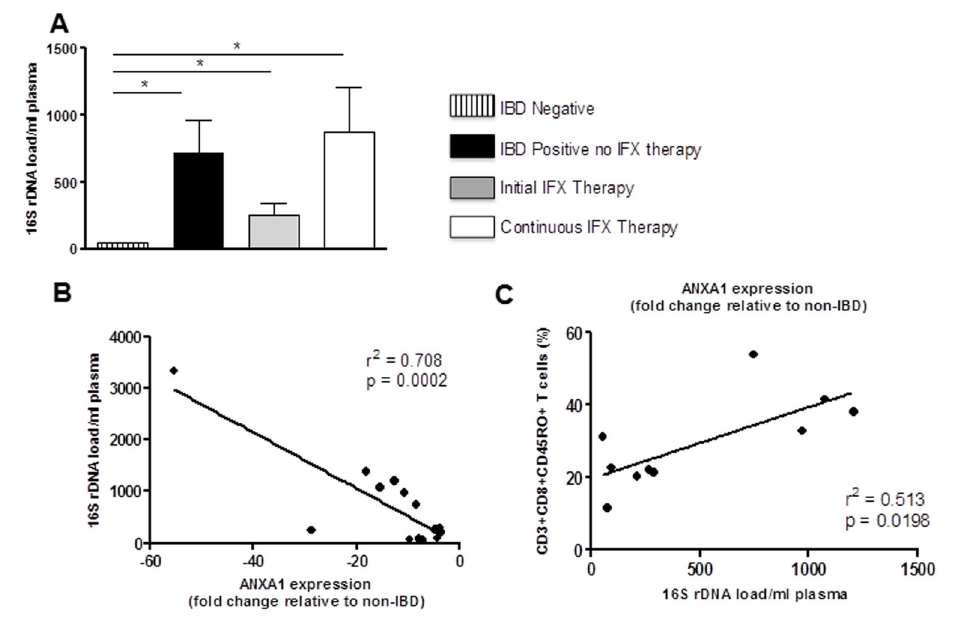
Figure 5. Plasma bacterial 16S ribosomal DNA (rDNA) correlates with IBD status, IFX therapy and ANXA1 expression. The number of 16S rDNA copies, was measured using quantitative PCR (qPCR). (A) An increase in the abundance of bacterial 16S rDNA in the plasma was observed in IBD patients (with and without IFX therapy) as compared to non-IBD controls. No significant difference was observed between patients initiating therapy and during IFX therapy. (*p<0.05) (B) An inverse correlation was observed between plasma 16S levels and ANXA1 expression. (C) A positive correlation was observed between plasma 16S levels and CD8+ CD45RO+ T cells (memory T